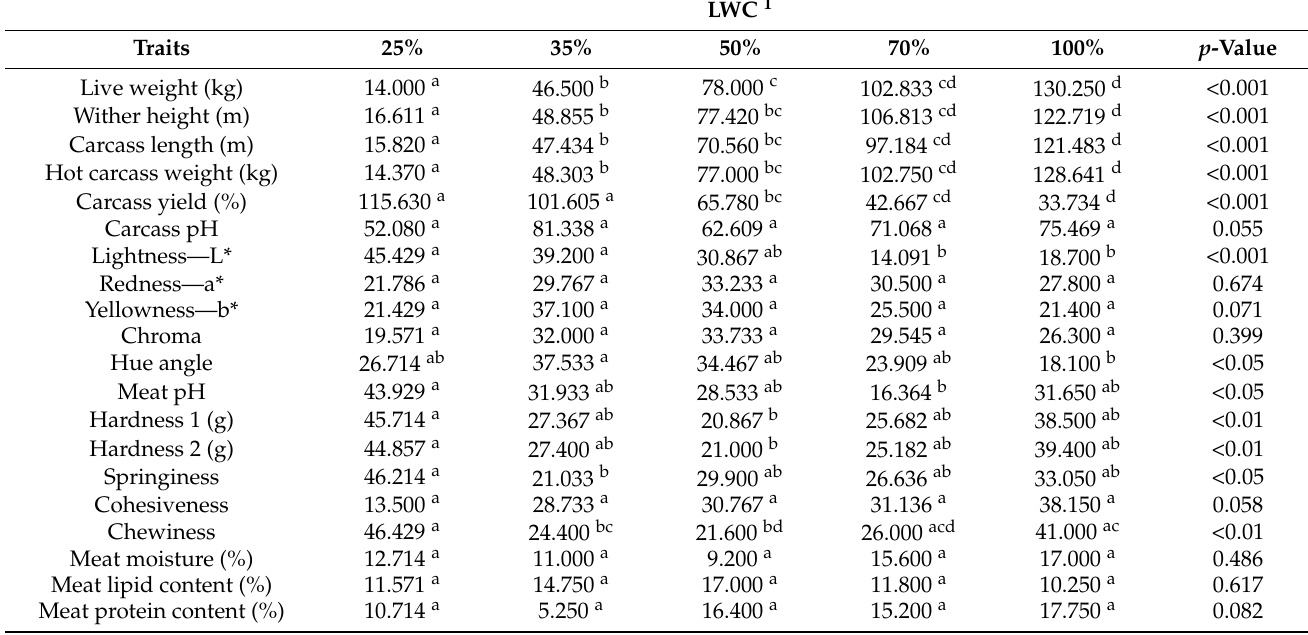
Table 4. Results of non-parametric Kruskal–Wallis one-way analyses of variance for assessing the statistical significance of the differences between mean ranks of the studied traits for different live- weight categories (LWC—% of mature live weight) of fat-tailed sheep (rejection of null hypothesis when p < 0.05: There are statistically significant differences between mean ranks of